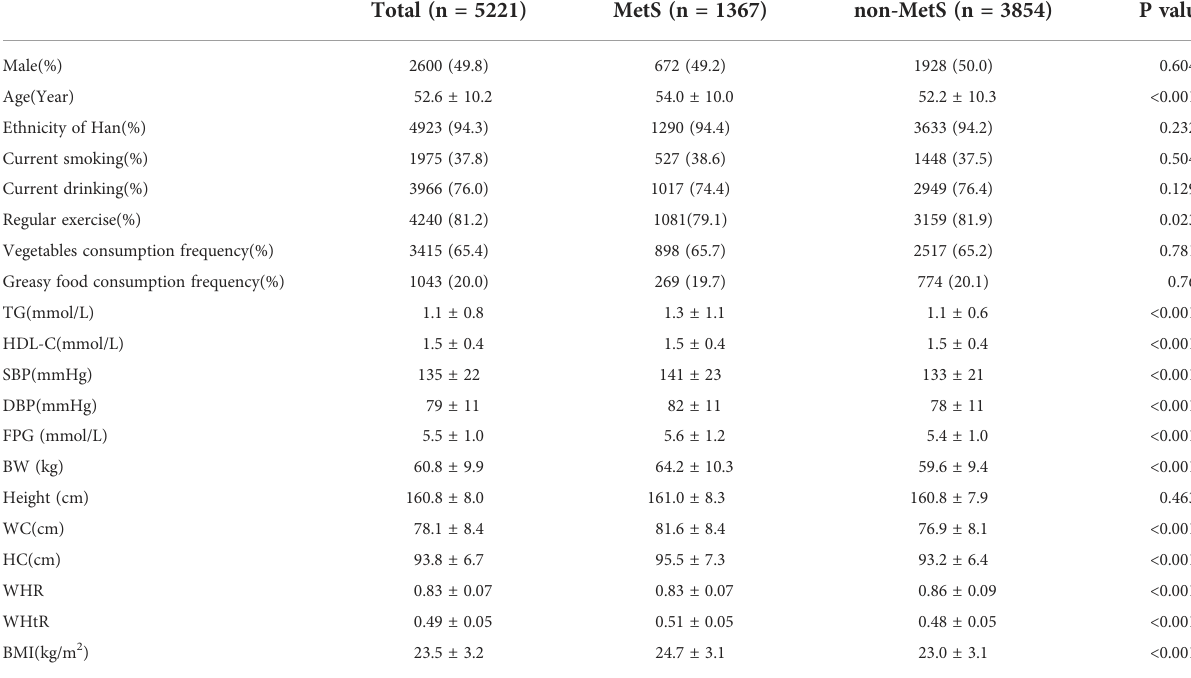
TABLE 1 Baseline characteristics of subjects grouped according to whether developed MetS at